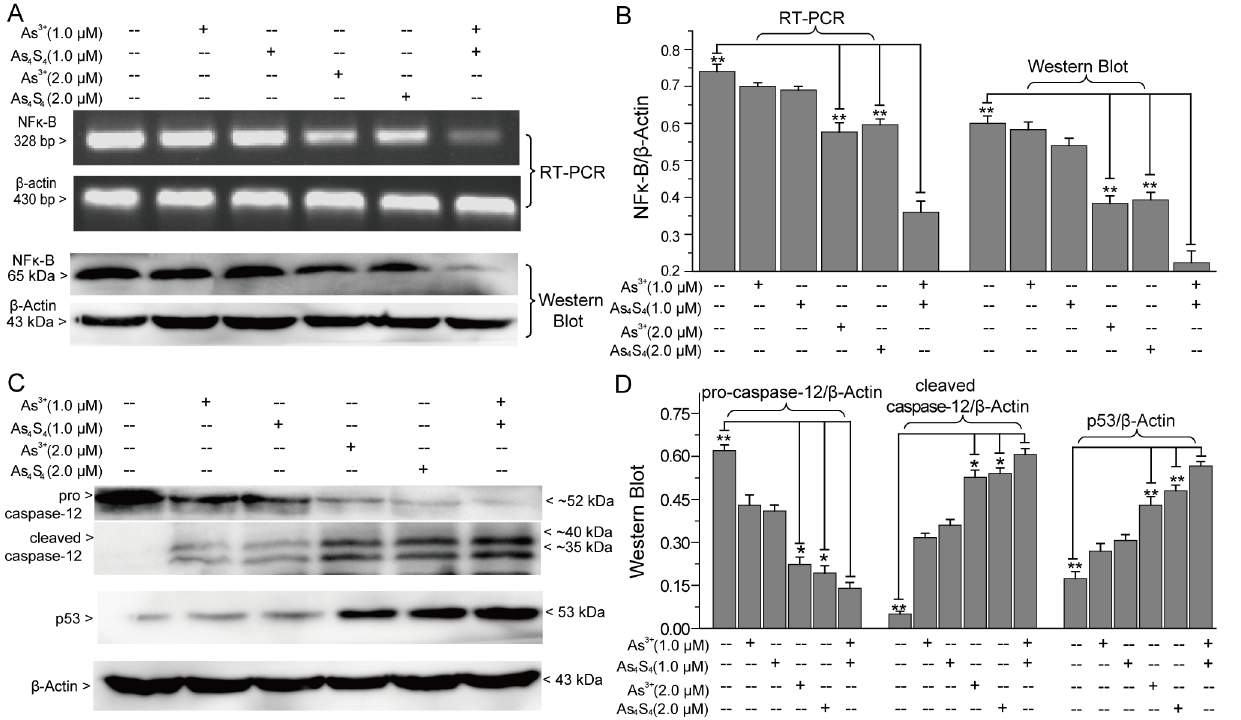
Fig 6. The effects of combining As 4 S 4 and As 3+ on NF κ B, caspase-12 and p53 expression. (A) RT-PCR and Western-blot analysis of NF κ B expression. (B) Relative NF κ B intensity obtained by RT-PCR and western-blot. (C) The effects of As 4 S 4 and As 3+ on caspase-12 and p53 expression. (D) Relative intensities of caspase-12 and p53 obtained by western-blot. Error bars represent the S.D. from the mean of three separate experiments. * P < 0.05 and ** P < 0.01 compared with As 3+ and As 4 S 4 combination treated cells.